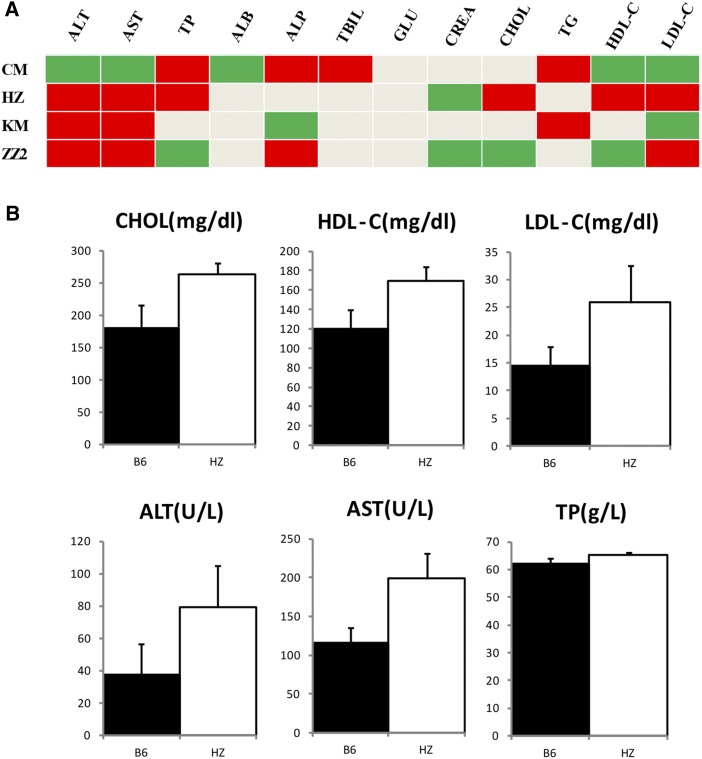
Comparison of phenotypes between C1SLs and recipient strain B6. (A) Comparison of 12 biochemistry indexes between CM, HZ, KM, and ZZ2, and recipient strain B6. Red: P < 0.01; green: P < 0.05. (B) Comparisons of six significant indexes between HZ and B6.